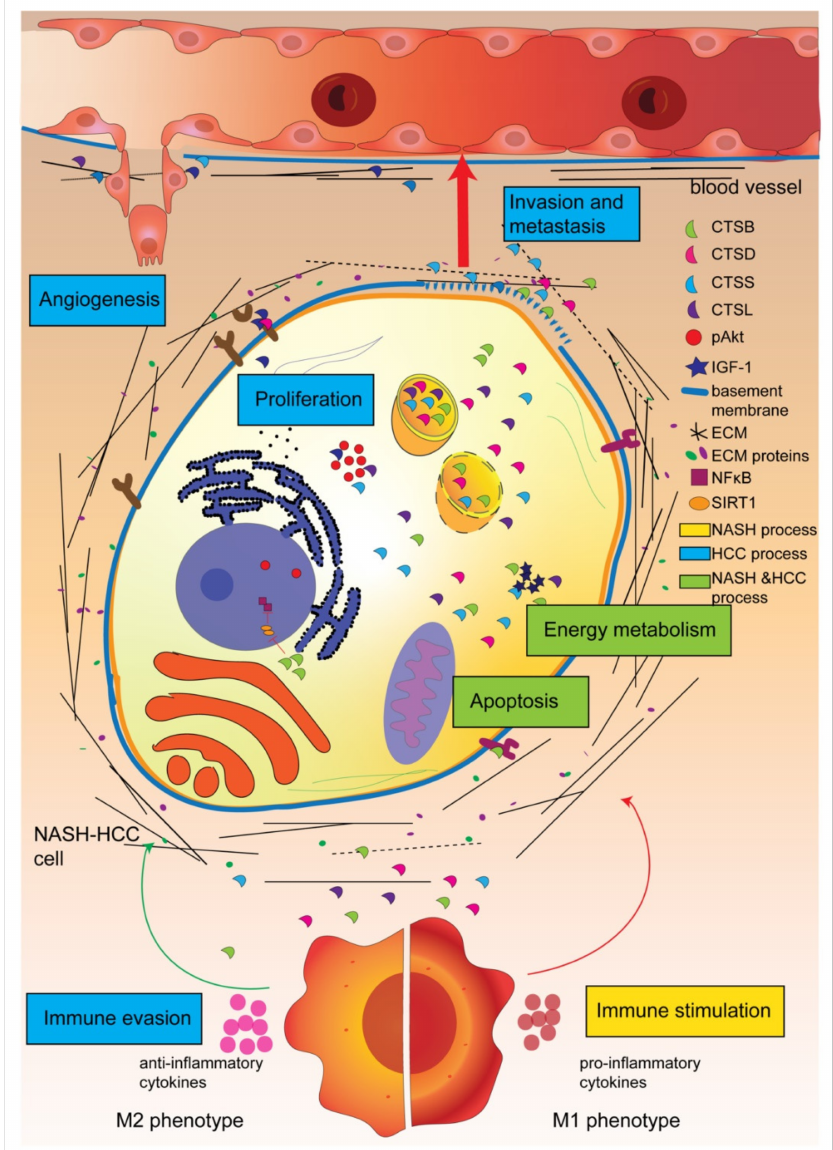
Figure 4. Conclusion and hypothesized working mechanism of cathepsins in NASH-induced hep- atocellular carcinoma (HCC). Cathepsins are involved in NASH through actions in (1)